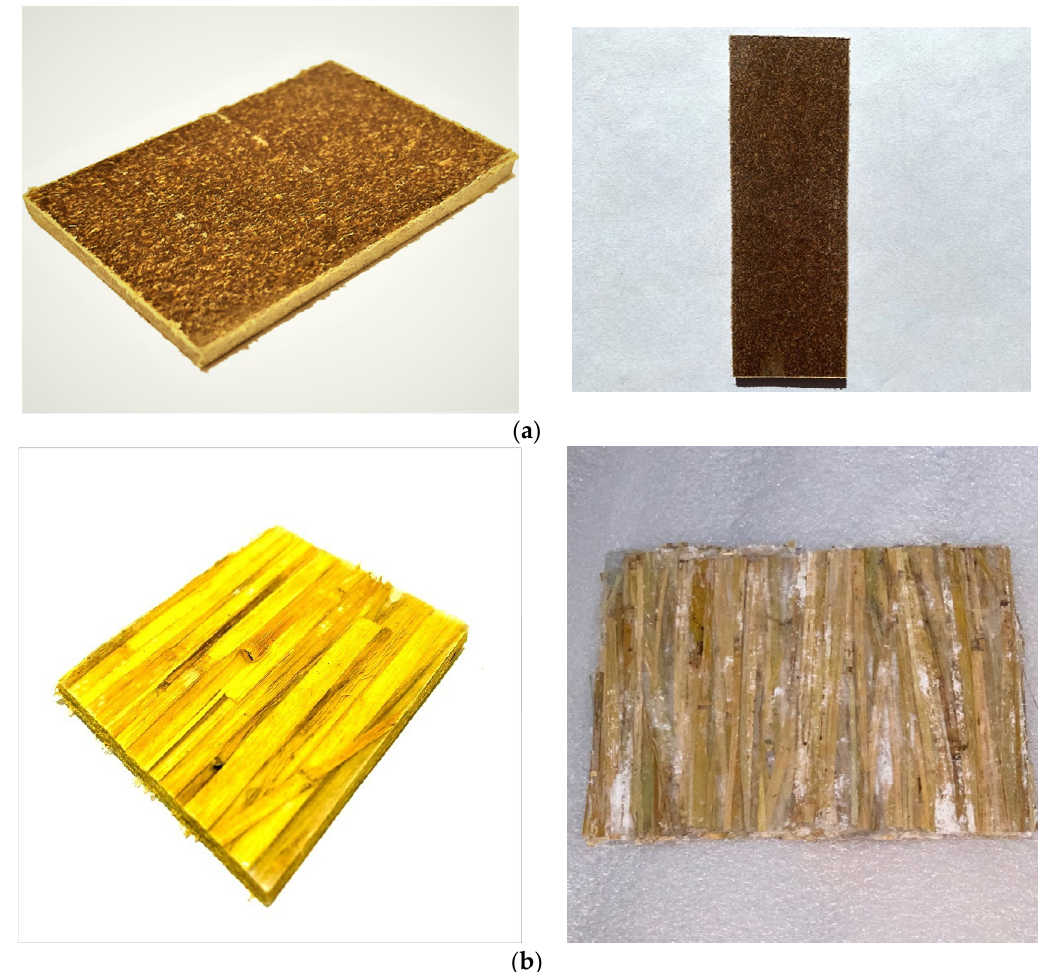
Figure 12. Extruded ( a ) and hot pressed ( b ) straw/LLDPE composites .